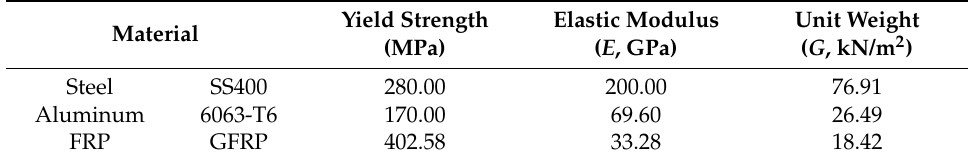
Table 8. Mechanical properties of steel, aluminum, and fiber reinforced polymer (FRP).